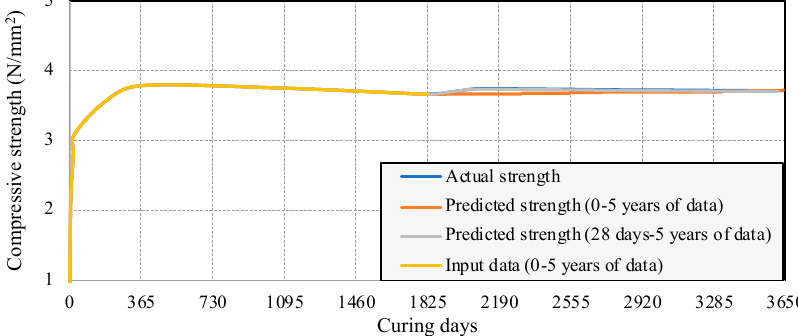
Figure 9. MLP model results for 10 years using the 5 ‐ year input data.